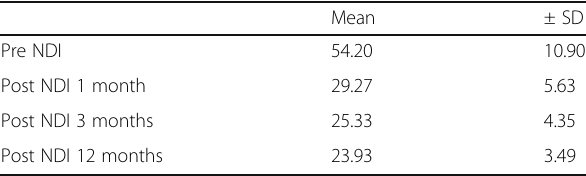
Table 4 Comparison between preoperative NDI and at different follow-up intervals among ACDF